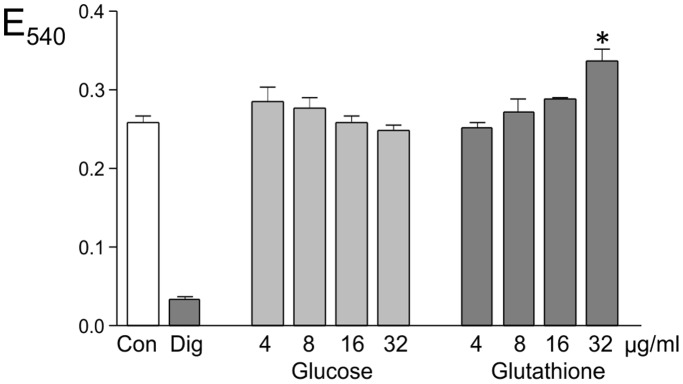
Viability of hCMEC/D3 cells treated with gold nanoparticles.Confluent monolayers of hCMEC/D3 cells were treated for 24 hr with different levels of either glucose-coated or glutathione-coated gold nanoparticles and viability was assessed by MTT assay. Values are mean and SEM of quadruplicate determinations (n = 4). The values were analysed by Anova (p<0.001) followed by Dunnet’s multiple comparison test, comparing each nanoparticle treatment with the untreated cells (Con). Only one treatment was significantly different from the control (*P<0.001). Digitonin-treated cells (Dig) were a positive control for cell death.